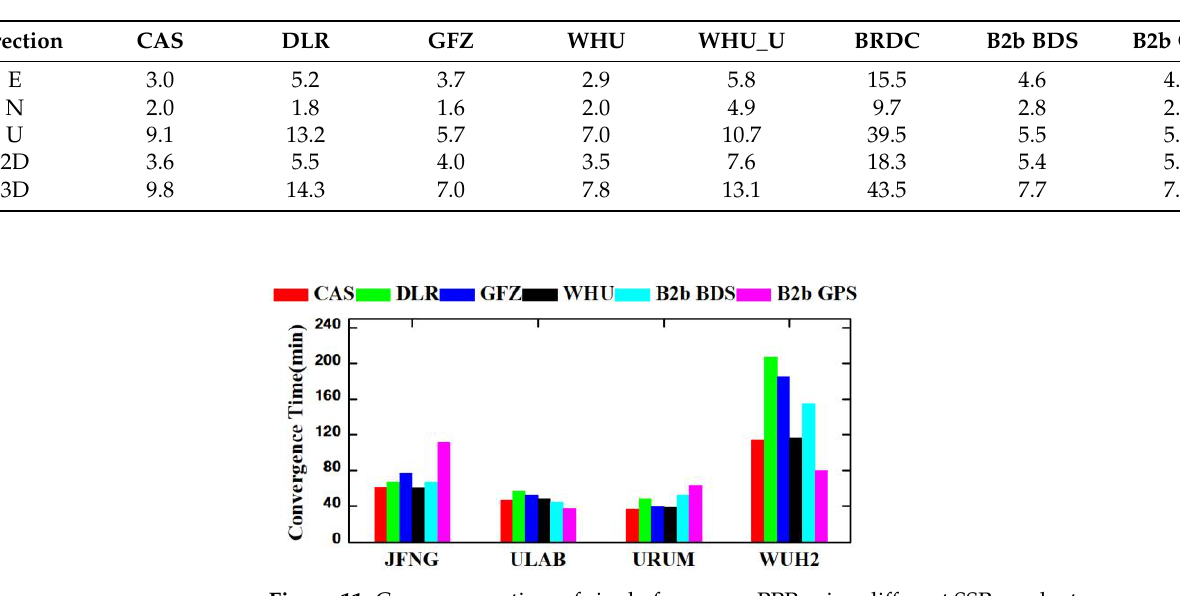
Table 6. The average positioning accuracy at the four stations (unit: cm).